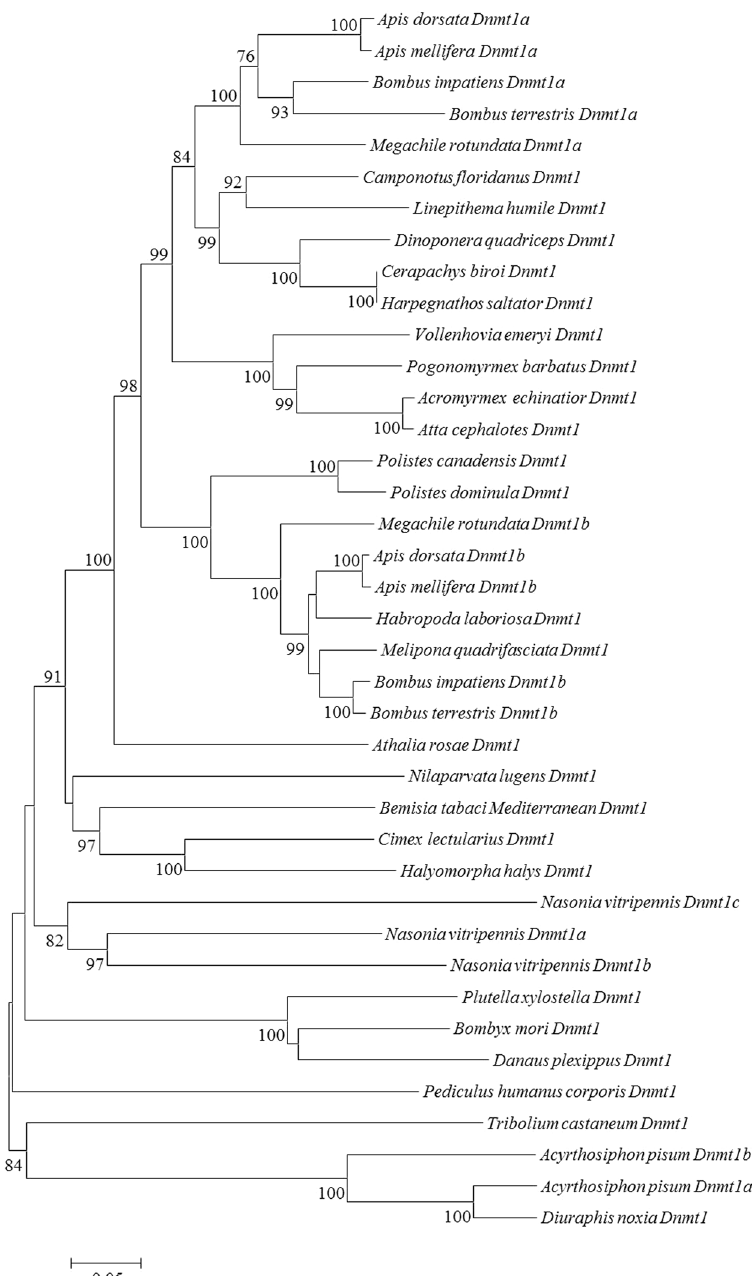
Figure 4. Phylogenetic relationships between Dnmt1 proteins from informative species. The phylogenetic tree was constructed with the maximum likelihood method using the MEGA 5 software. Bootstrap majority consensus values for 1,000 replicates are indicated at each branch point (%). The scale bar represents the branch length, which indicates an evolutionary distance of amino acid substitutions per